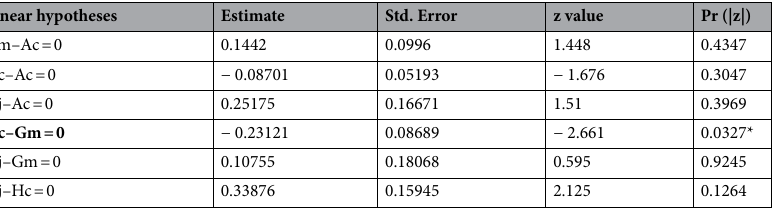
Table 5. Multiple comparison for the variable fish species for the positive frequency of parasitized fish larvae, applying a Gamma Model (see Table 1). Hc, H. cunninghami ; Gm, G. marmoratus ; Ac, A. crinitus ; Oj, O. jenynsi. *Significant at P < 0.05.